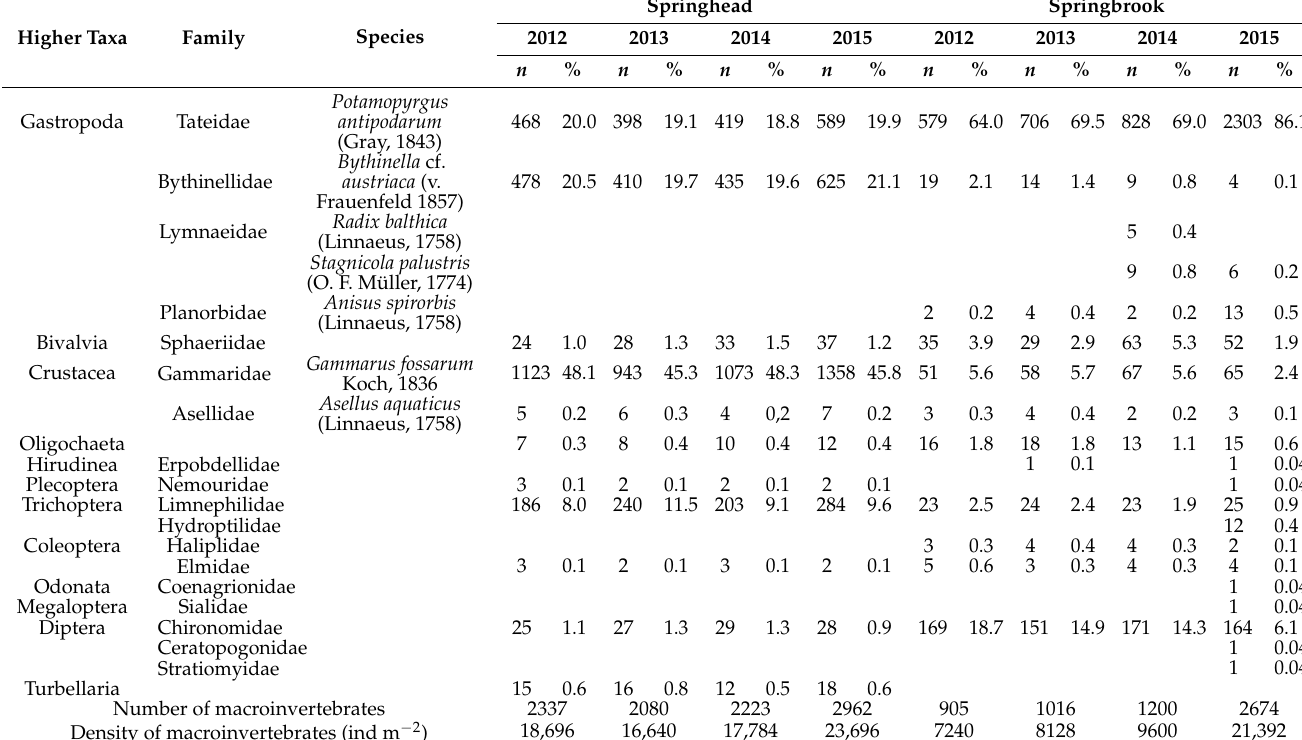
Table 3. Macroinvertebrate taxa at the sampling sites (n—number of individuals, %—percentage